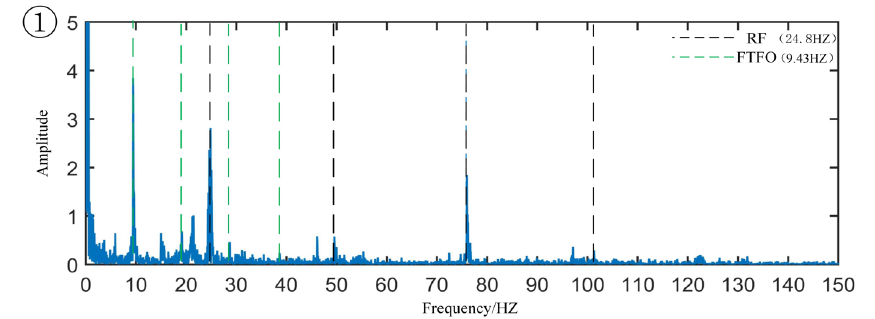
Figure 9. Minor fault signal envelope spectrum.